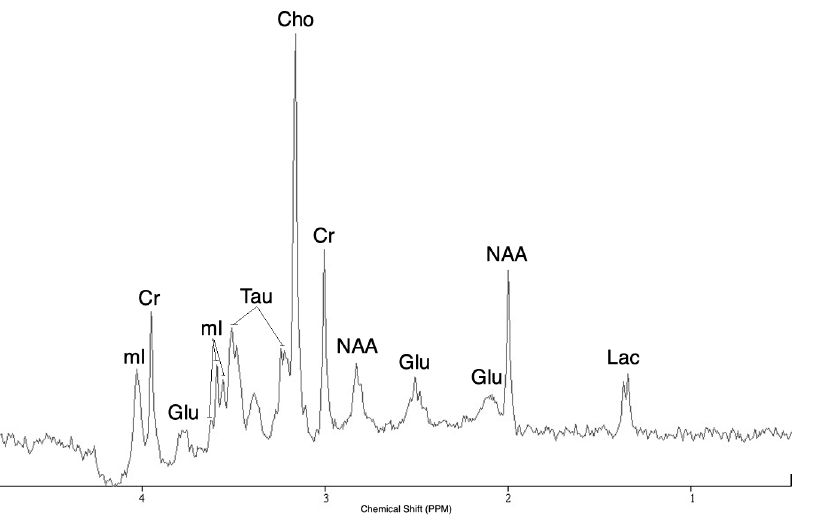
Figure 1. In vitro 1 H spectrum of the solution of 7 brain metabolites with a concentration fixed at 25 mM acquired with the microcoil (detection volume: 0.450 µ L) at 7 T using the PRESS sequence (TR/TE = 2000/15 ms, Nacc = 256, Tacq = 8 min 32 s). Based on the characteristics of the different metabolites studied [9], the intensities of the resonance peaks correspond to